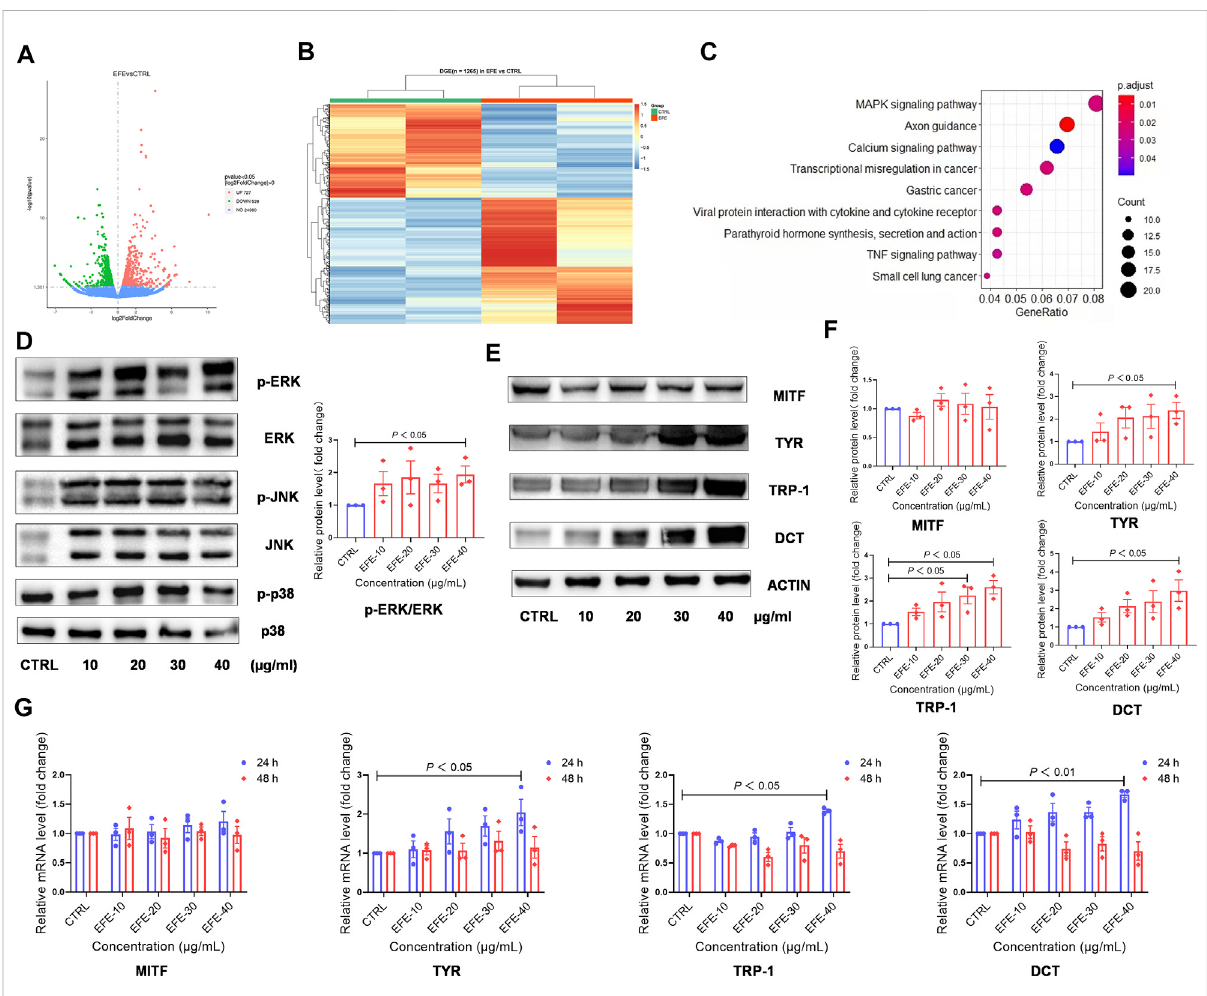
FIGURE 5 EFE upregulates theexpression of melanogenesis-relatedgenes and proteins through theMAPK/ERK1/2 signal pathway for melanogenesis. (A) Volcano plots, 727 upregulated differential genes, 538 downregulated differential genes, and 24,380 undifferential genes between CTRL and EFE groups; (B) heat map of 1,265 differential genes between CTRL and EFE groups; (C) KEGG signal pathways analysis of 1,265 differential genes; (D) protein expression levels of p-ERK, ERK, p-JNK, JNK, p-P38, and P38 and statistics for p-ERK/ERK expression (40 μ g/ml, 72 h); (E) protein expression levels of MITF, TYR, TRP-1, and DCT (40 μ g/ml, 72 h); (F) statistics for MITF, TYR, TRP-1,and DCT expression; (G) mRNA expressionlevels ofMITF,TYR,TRP-1,andDCTgene(40 μ g/ml).Forgraphicalrepresentation,transcriptomedataarefromnormalhumanforeskin-derivedepidermal melanocytes, n = 2; data are presented as mean ± SEM ( n ≥ 3 in each group), p < 0.05, p < 0.01, and p < 0.001 vs. CTRL are considered signi fi cant. Representative image from three independent experiments is